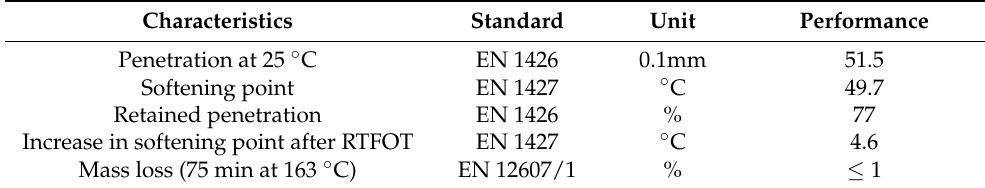
Table 1. Main characteristics of the reference plain bitumen.